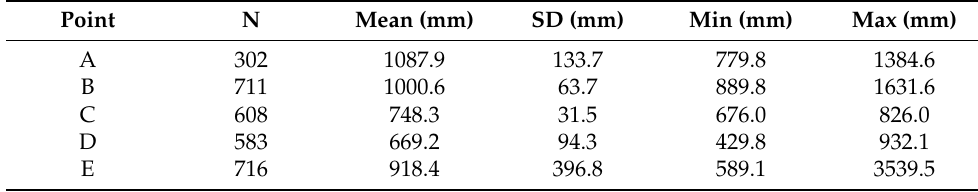
Table 3. Measurement error at each